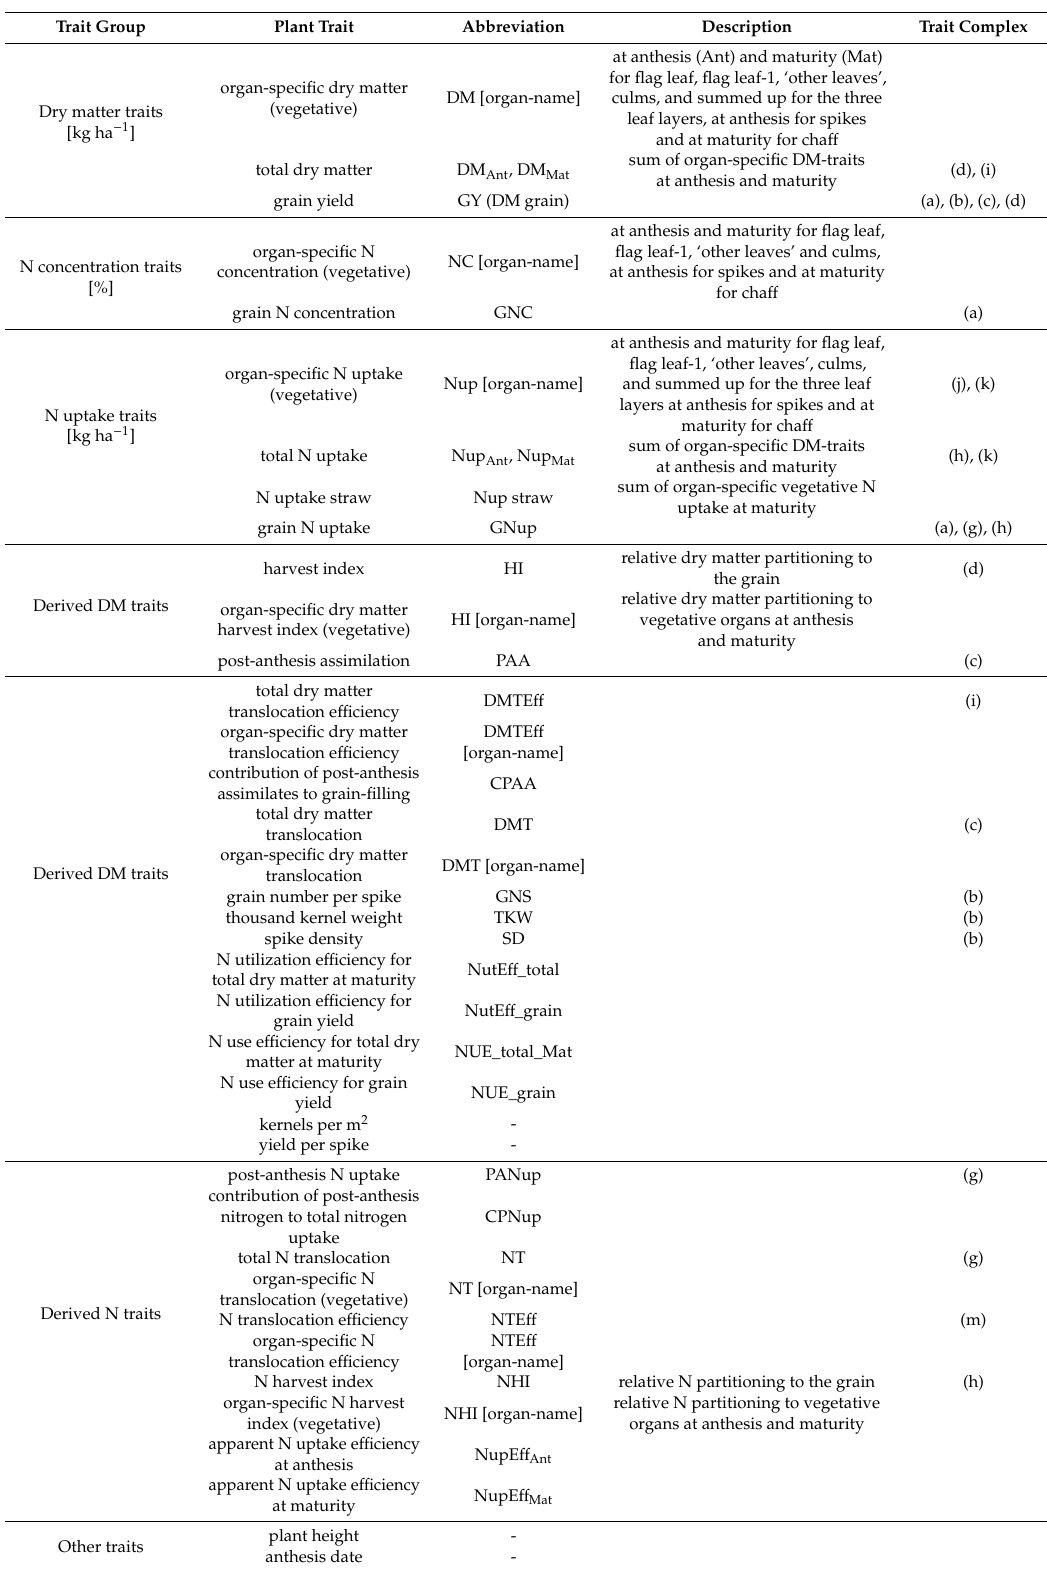
Table 2. List of plant traits considered in this study, grouped by trait groups. See Table 3 for equations of derived, calculated plant traits. Corresponding trait complexes are indicated as described in Equation